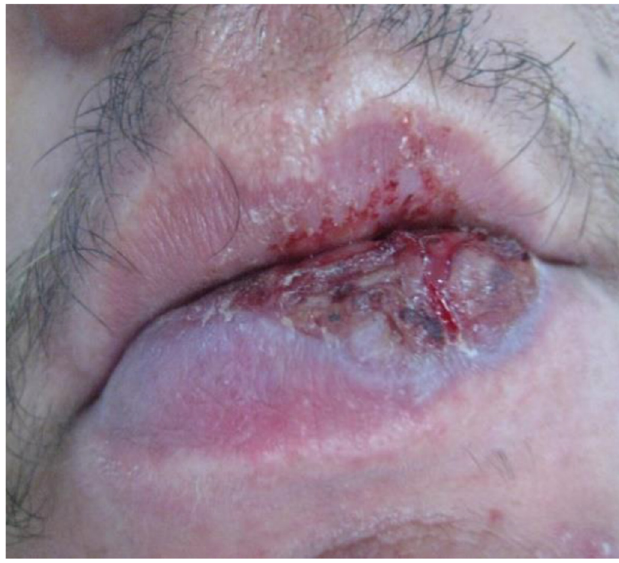
Fig. 1. Crusted hemorrhagic ulceration along the lower lip with lacy white streaks on the lateral border of the lesion.